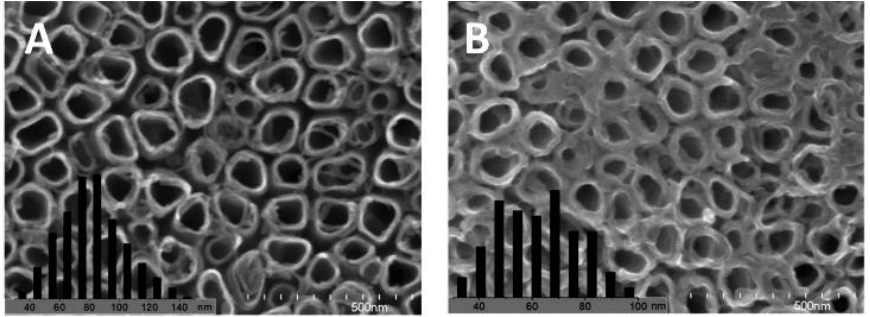
Figure 3. SEM images of electrochemical polymerization of PEDOT in TiO arrays: ( A ) initial TiO nanotube arrays; ( B – E ) different stages of the polymerization of 2 EDOT on the substrate. Reproduced with permission from [169], Copyright 2010, American Chemical